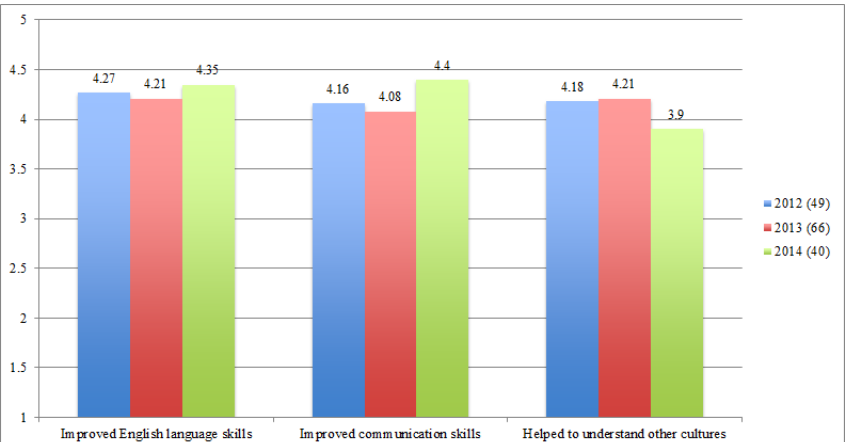
Figure 4. Mean rating of the personal experience of the outcomes of Week